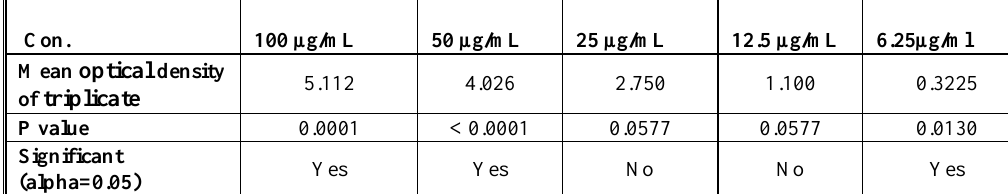
Table 4. The statistical result of the cytotoxicity of different concentrations from the tested sample (aqueous layer) against Vero